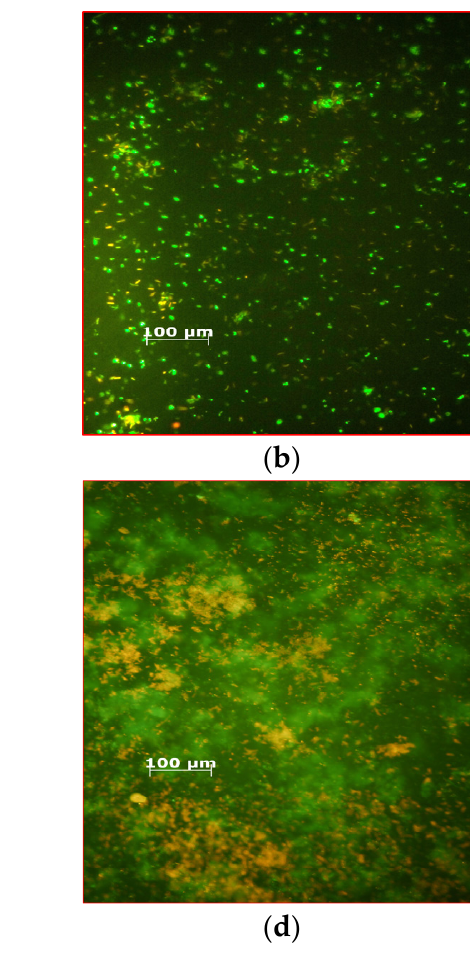
Figure 4. Fluorescence microscopy images of biofilm formed on the glass surface by S. aureus 3515 before aPDI ( a ); after photodynamic inactivation with MB alone as a photosensitizer ( b ); after photodynamic inactivation with MB + AuBNPs as a photosensitizer ( c ); after photodynamic inactivation with MB+AuChNPs as a photosensitizer ( d ). In the presence of the SYTO 9 and propidium iodide mixture, bacteria with intact cell membranes stain fluorescent green, whereas bacteria with damaged membranes stain fluorescent red. Scale bar: 100 μ m.